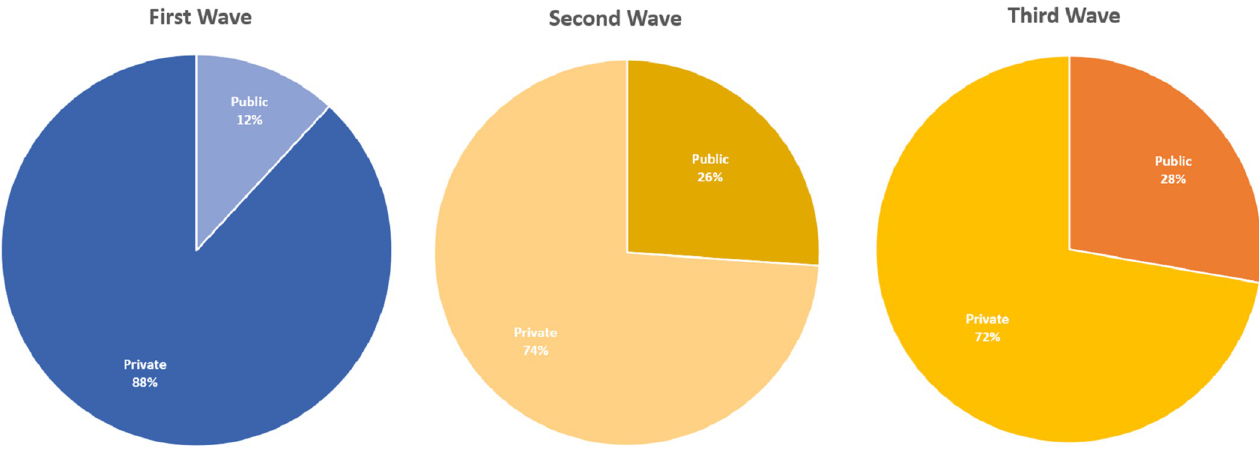
Fig 4. Proportion of patients hospitalized to HC/ICU beds in public and private sectors during the three waves.